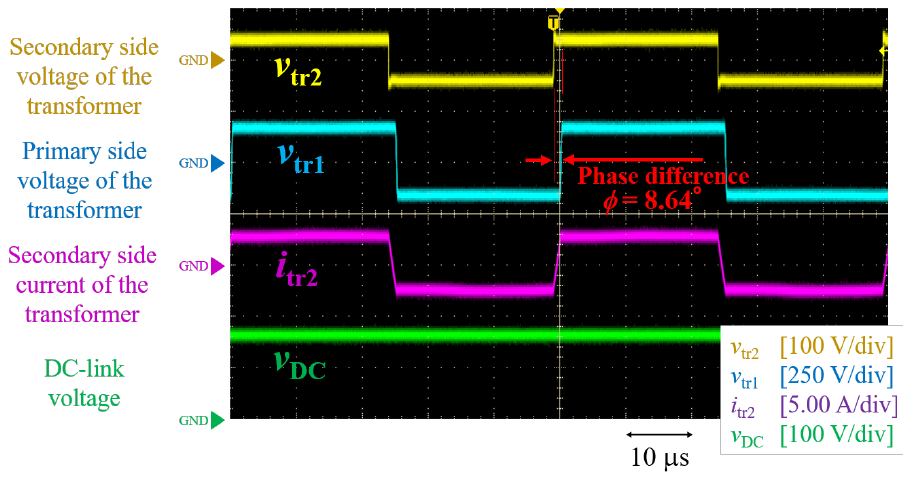
Figure 16. Experimental results of DAB converter when v bat = 40.8 V.